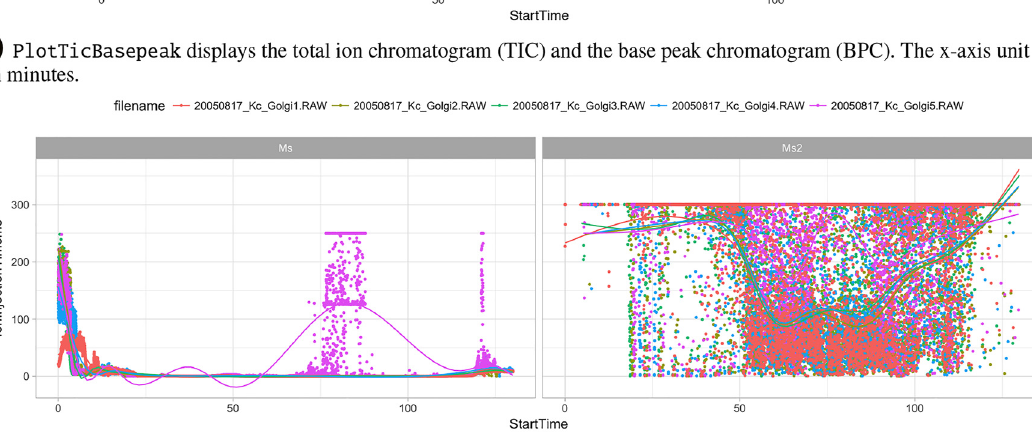
Figure 7: Example 2 – visual exploration using the R command